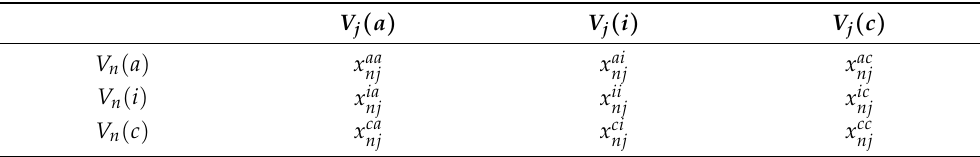
Table 1. Dependency matrix X nj